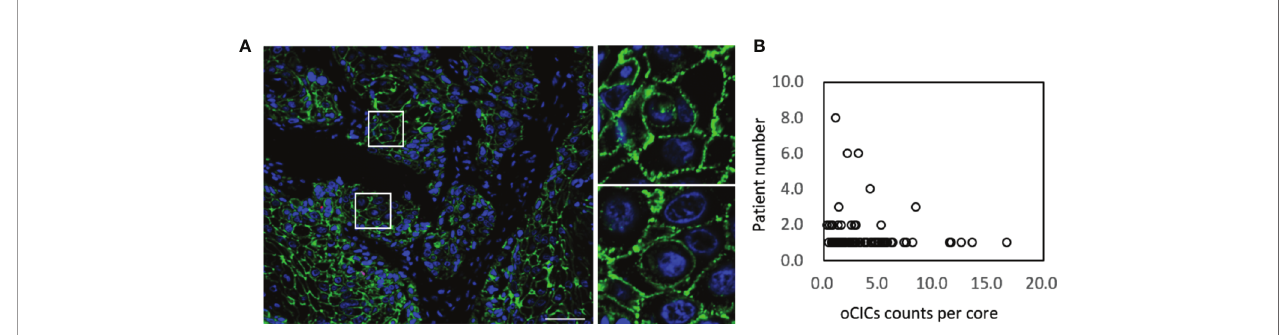
FIGURE 1 | Cell-in-cell structures in esophagus carcinoma. (A) Representative image for CICs in human esophagus carcinoma co-stained with antibodies for E- cadherin, CD45, CD68 and DAPI. Right panels show zoomed images for boxed regions in the left image. Scale bar: 100 m m. (B) Distribution of overall CICs (oCICs) across esophagus carcinoma tissues from different patients.